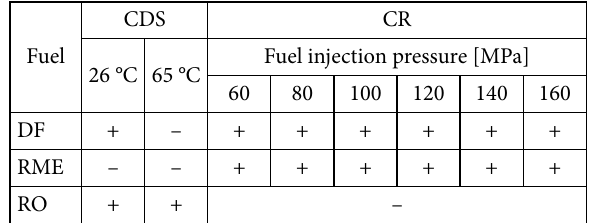
Table 2. The plan of the experiment